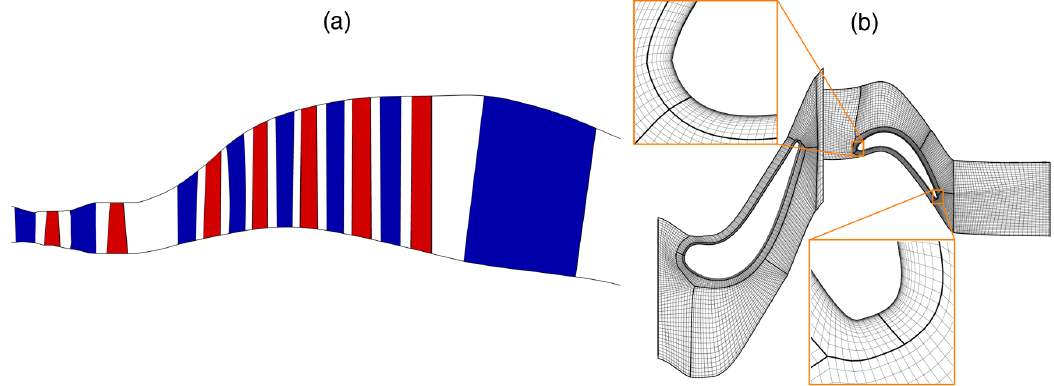
Figure 8. ( a ) Cross-view of the investigated turbine geometry; ( b ) computational grid of the first high pressure turbine (HPT) stage [81].